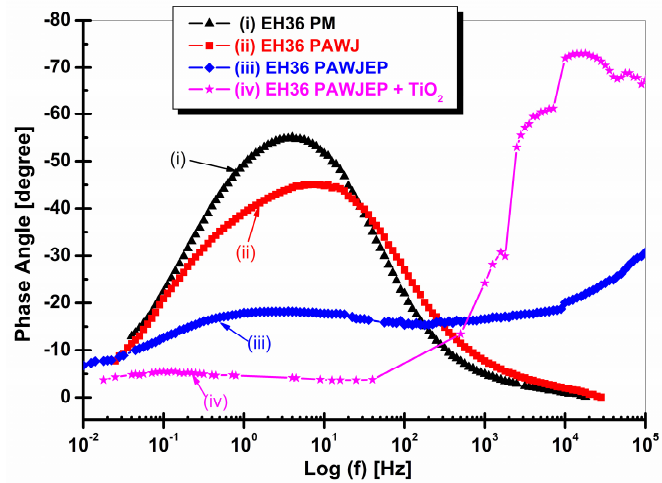
Figure 12. Electrochemical impedance spectroscopy diagrams in Bode representation as Phase angle vs. log frequency for: (i) EH36PM without protective coating used like parent material, (ii) EH36PAWJ welded steel without protective coating, (iii) EH36PAWJEP coated with polymeric primer and (iv) EH36PAWJEP + TiO 2 coated with nanocomposite polymeric primer with dispersed TiO 2 nanoparticles.